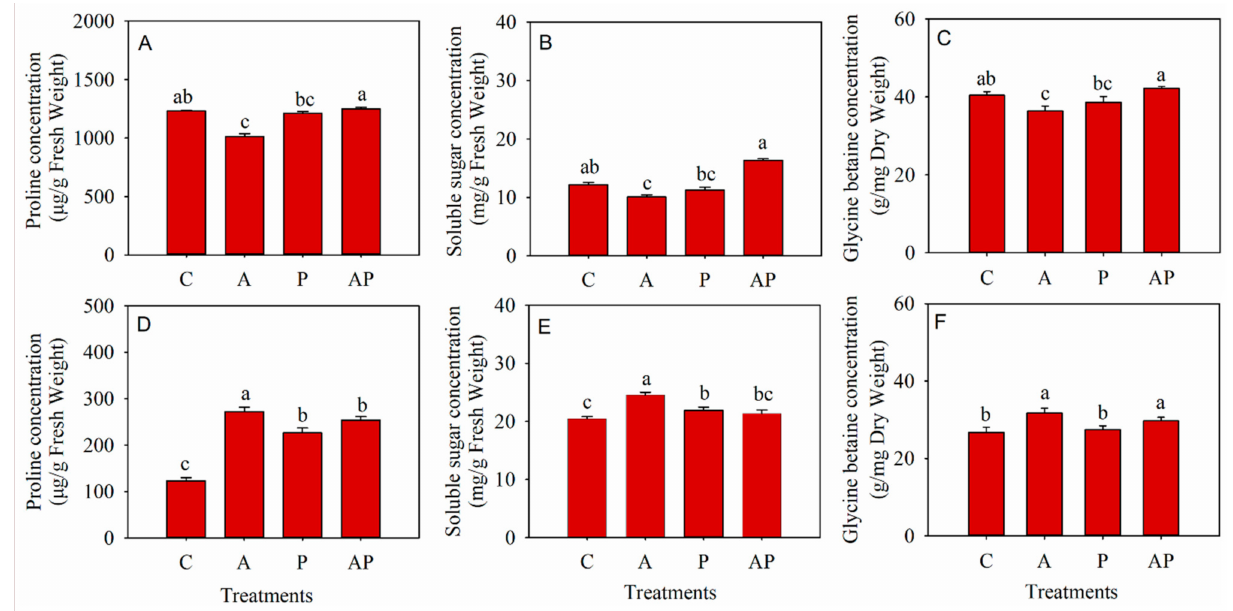
Figure 7. Effects of microbial inoculation on the proline ( A , D ), soluble sugar ( B , E ), and glycine betaine ( C , F ) concentration in the leaves of Nitraria tangutorum Bobr. (first row) and Elaeagnus angustifolia Linn. (second row). Each value represents the mean of three replicates. Each bar represents the standard deviation of three replicates. Values are significantly different at the 0.05